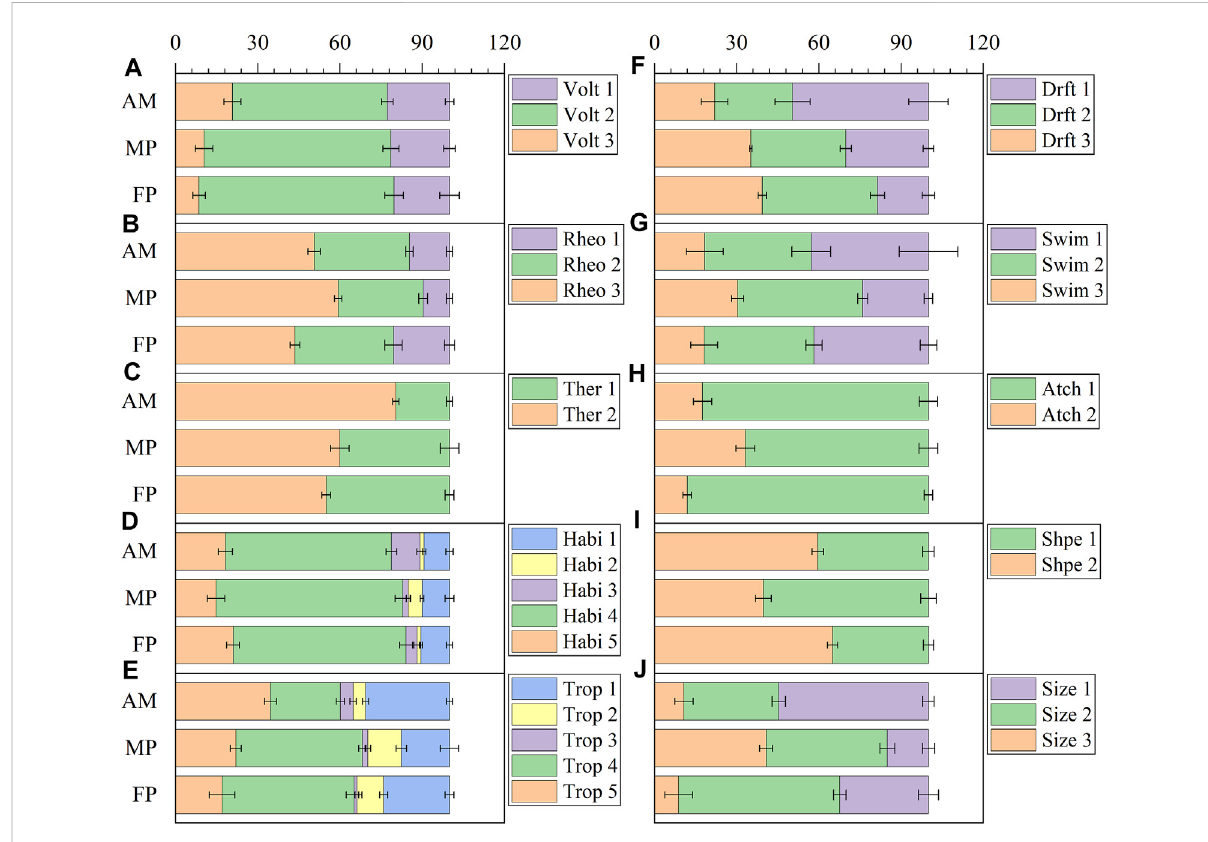
FIGURE 4 Average percentage of functional traits of macroinvertebrates during three periods of snow melt (FP, freezing period; MP, melting period; AM, after the melting period): voltinism (A) , rheophily (B) , thermal preference (C) , habit (D) , trophic habit (E) , occurrence in drift (F) , swimming ability (G) , attachment (H) , shape (I) and size at maturity (J) . Different lowercase letters indicate signi fi cant differences in invertebrate community structure caused by different periods. Data are shown as mean ±